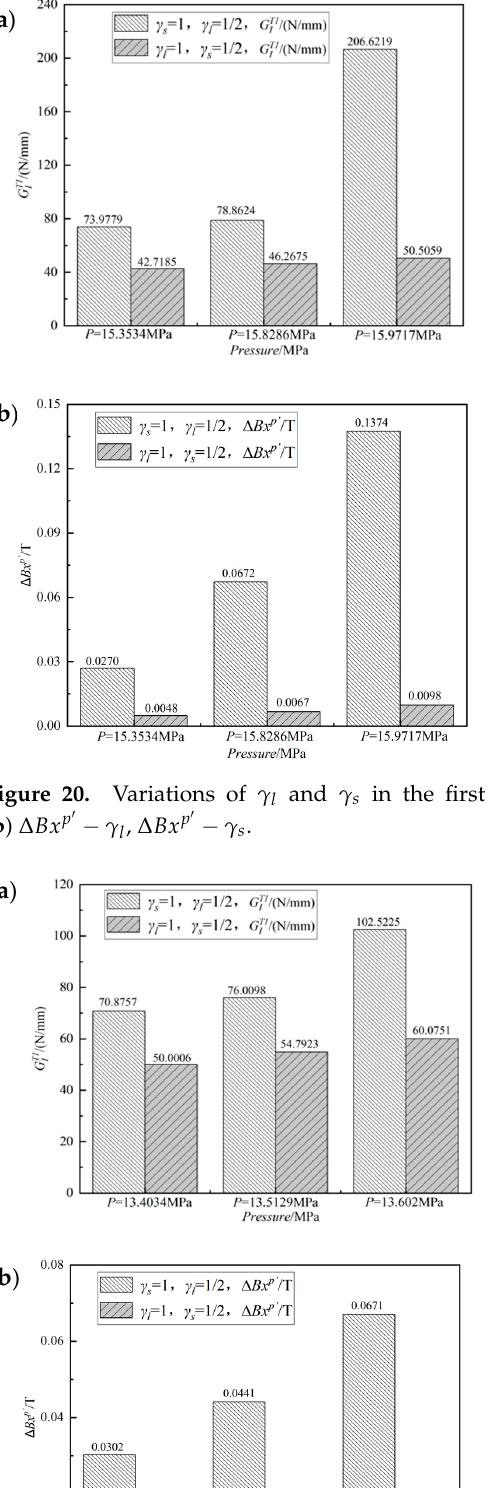
T 1 − γ − γ s l , G I I